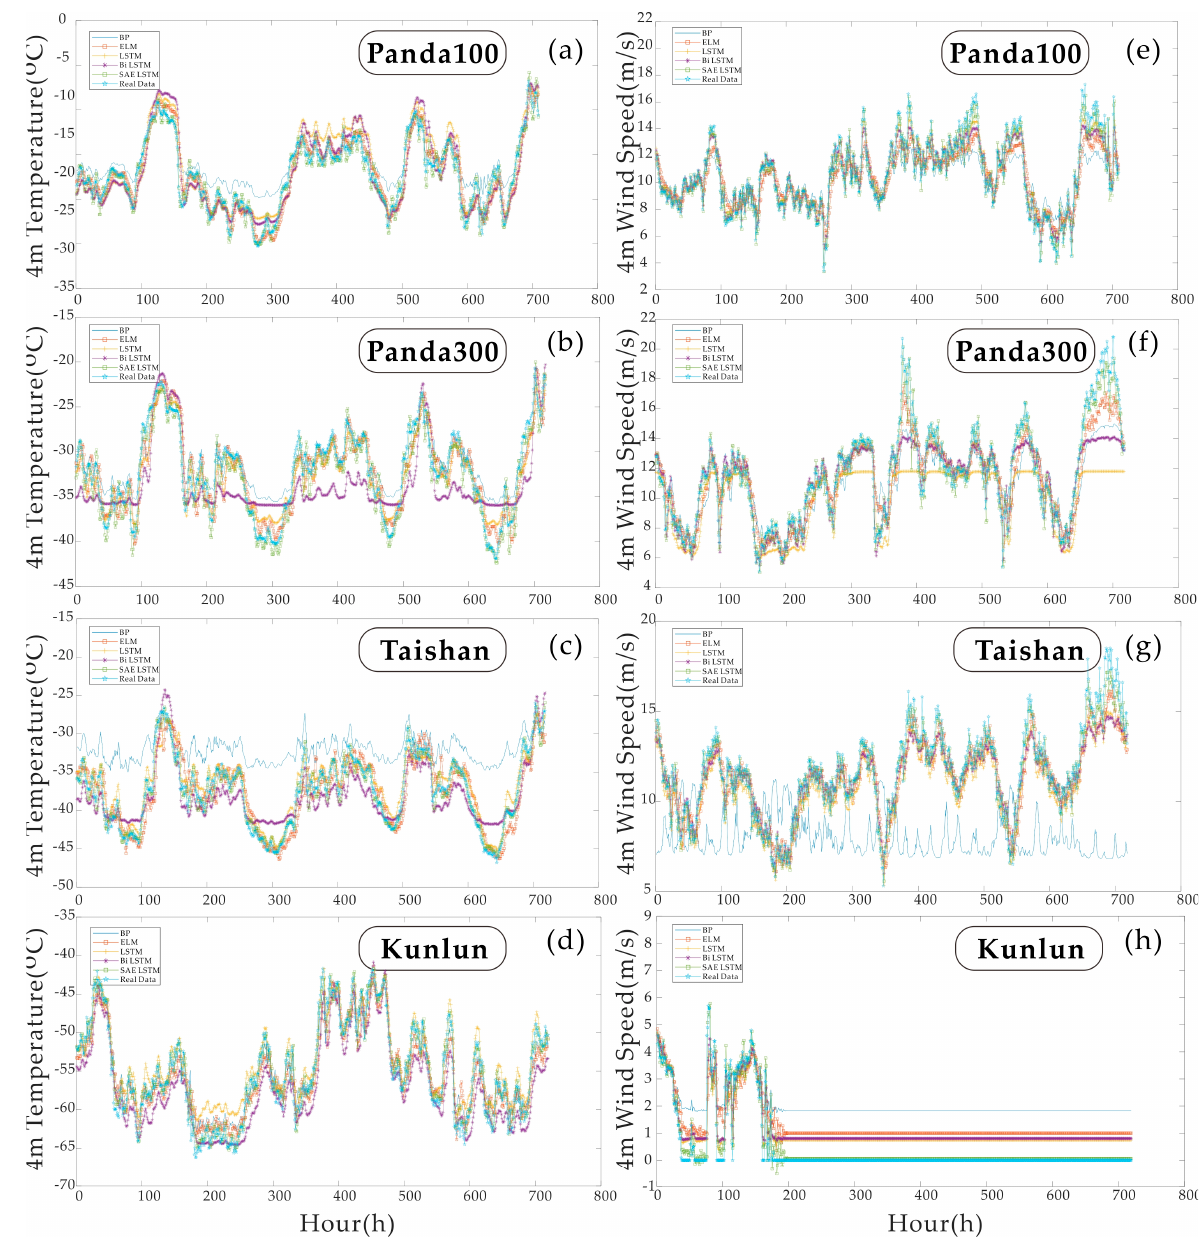
Figure 11. Results of multi-step predictions: ( a – d ) are the results of the 4 m temperature multi-step predictions for the four sites. ( e – h ) are the results of the multi-step prediction of the 4 m wind speed for the four areas.